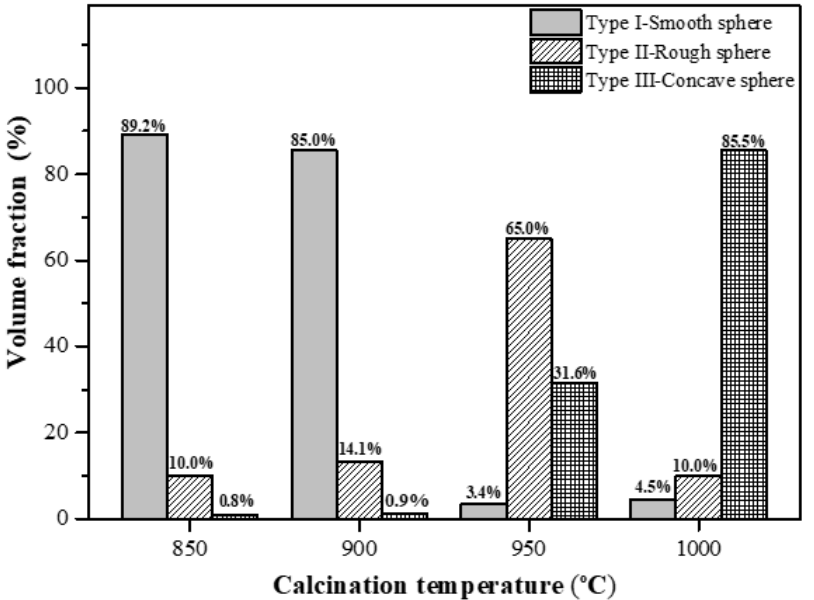
Figure 5. Morphology distributions of Mg 2 SiO 4 powders calcined at temperatures of 850, 900, 950, and 1000 °C.